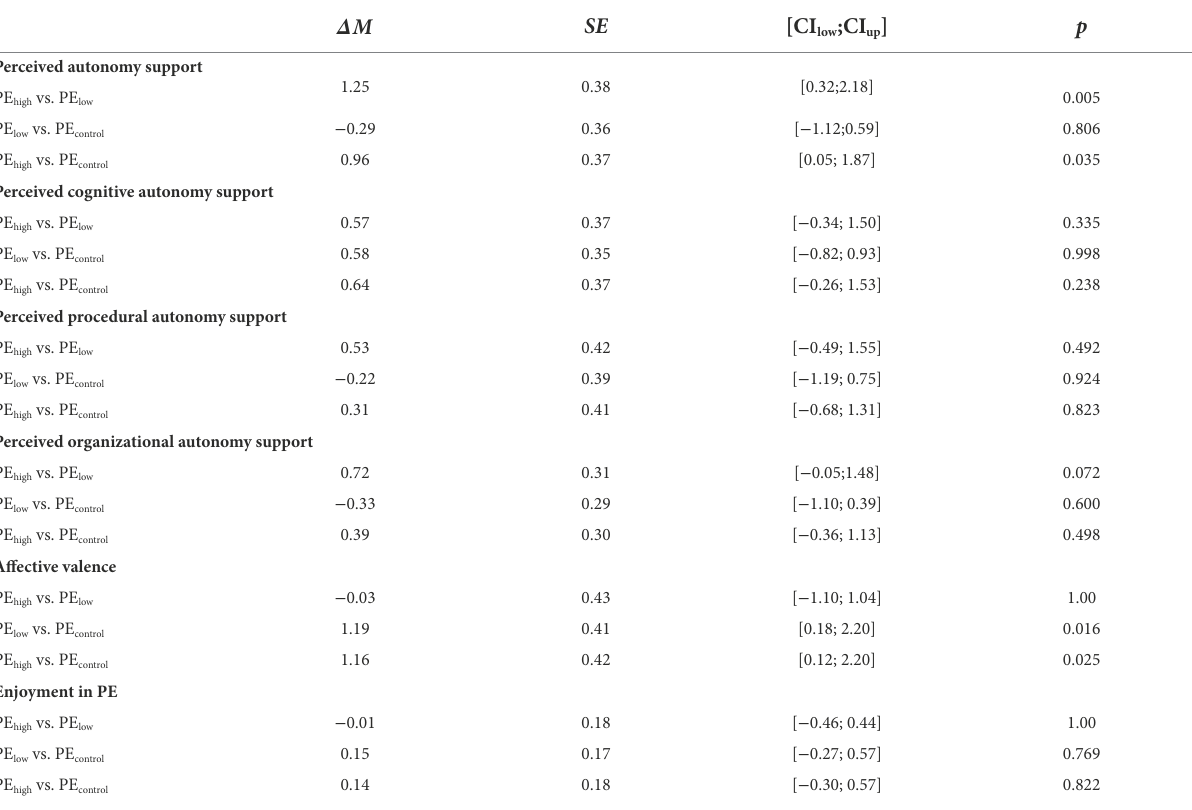
TABLE 3 Results of Gabriel post-hoc -comparison tests: Comparison of PE subgroup differences at post-measurement for the variables perceived autonomy support, affective valence, and enjoyment in PE. Δ M